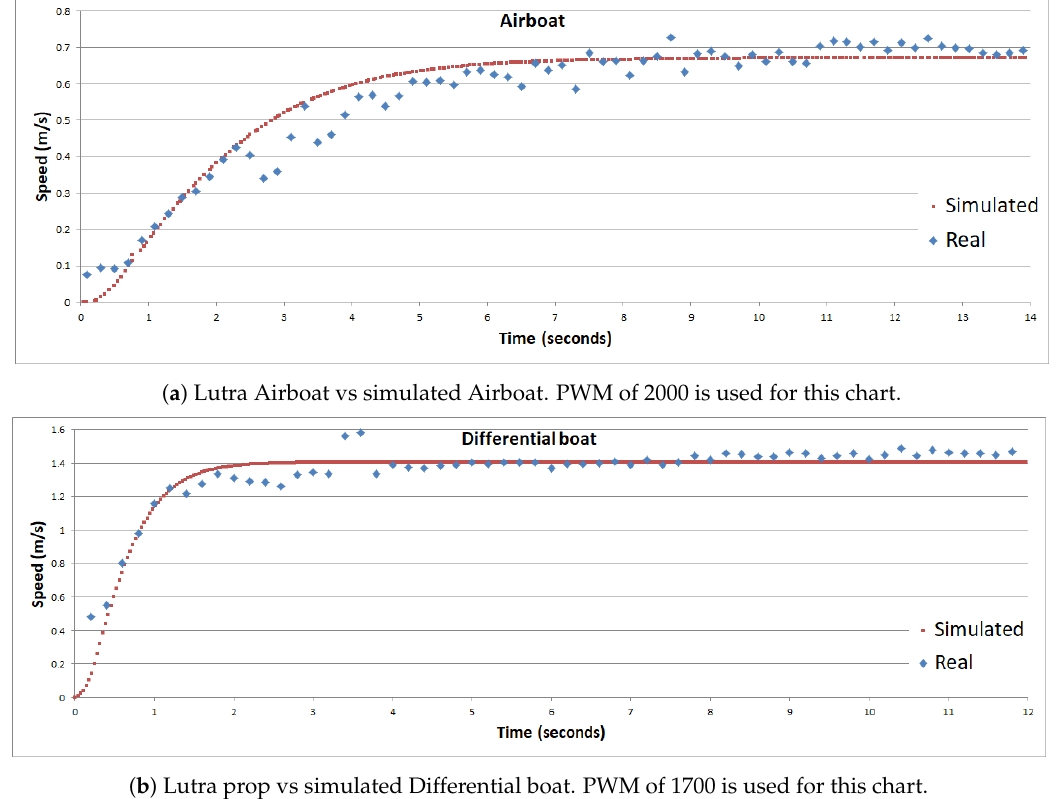
Figure 7. Comparison of speed trials between physical and simulated